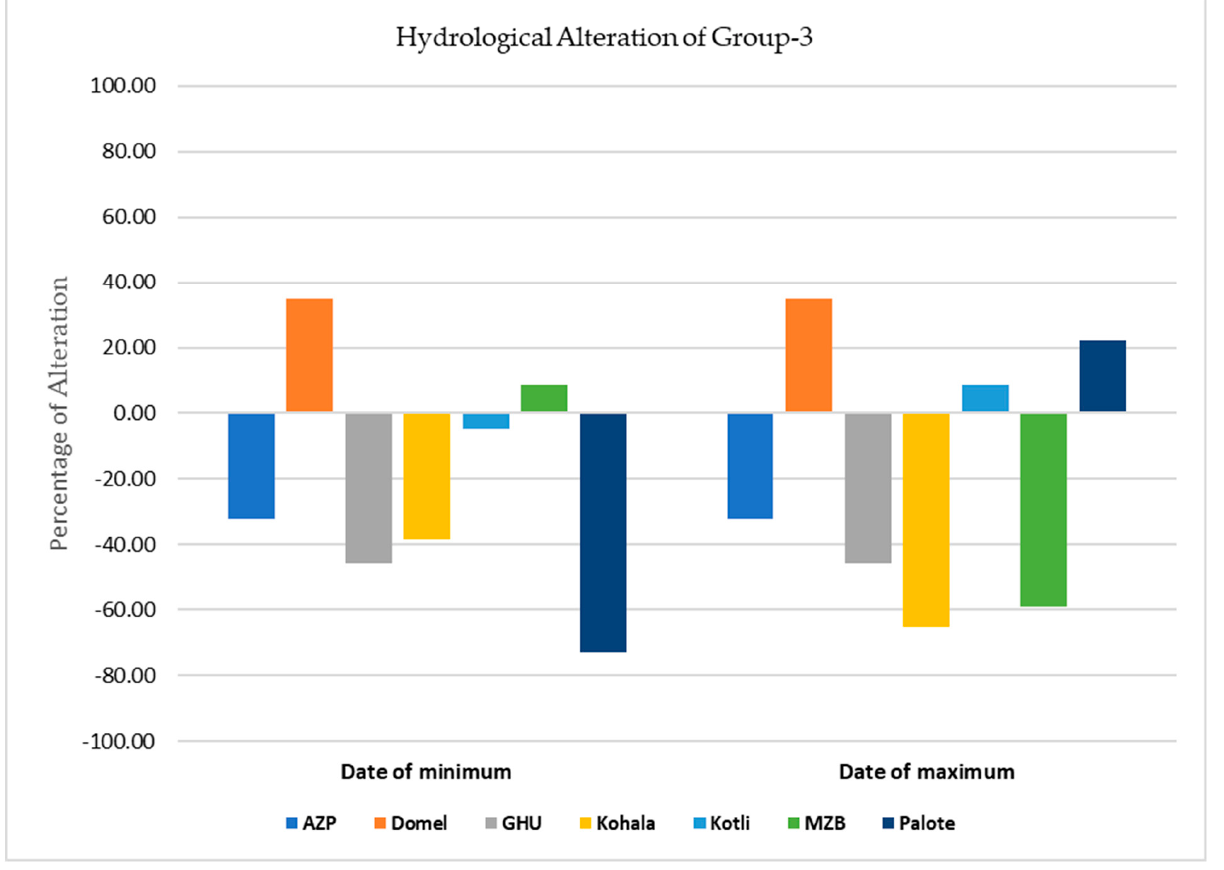
Figure 5. Hydrological Alteration of Group − 3 indicators.